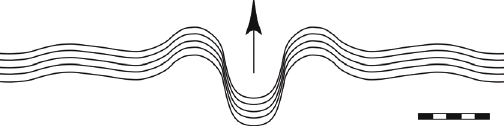
Fig. 53. Lituites tenuicaulis Remelé, 1890 from the Upper Grey Orthoceratite Limestone; lirae in specimen MB.C.30551 (Münchner Coll.) from Island of Chrząszczewska (former Gristow; West Pomerania, Poland), at wh = 12.5 mm. Scale bar units = 1